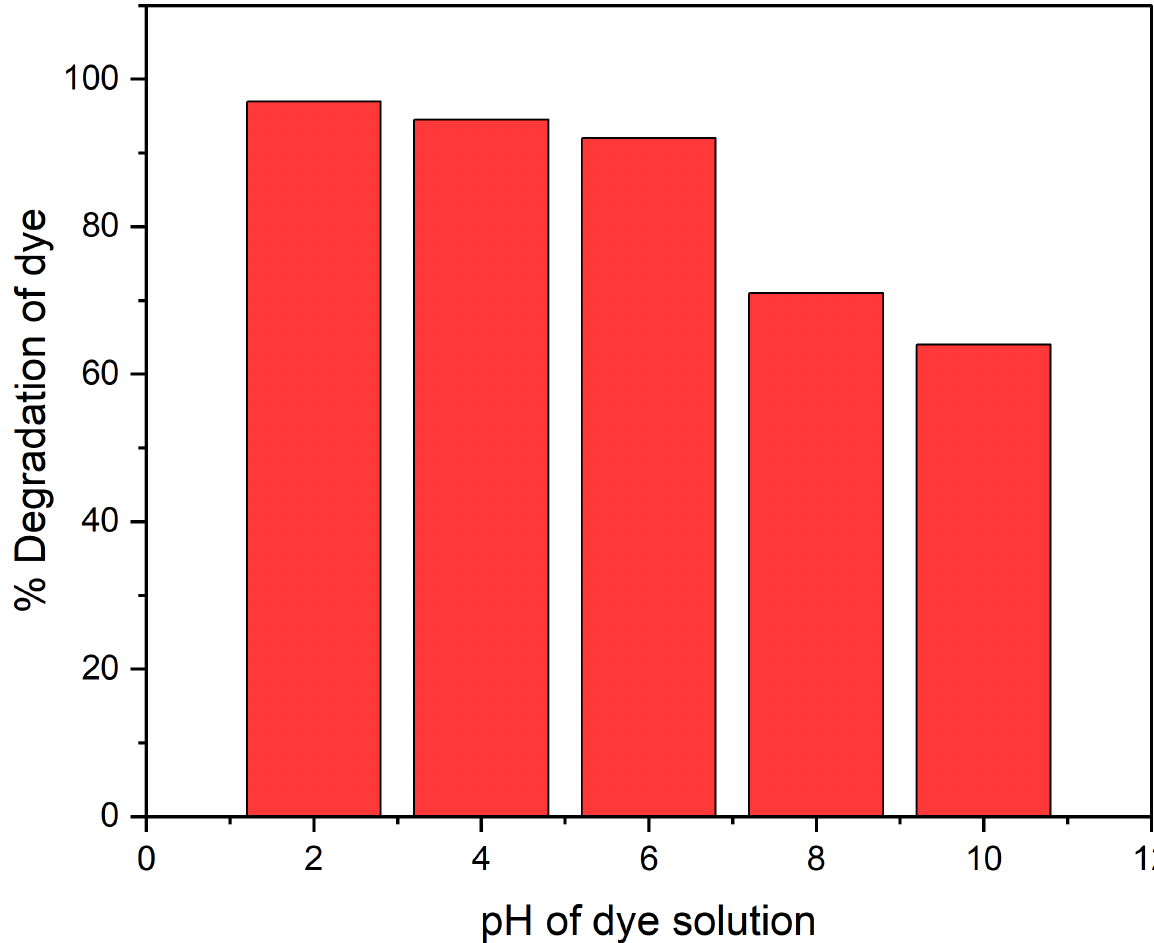
Figure 5. pH effect on CR dye degradation under UV